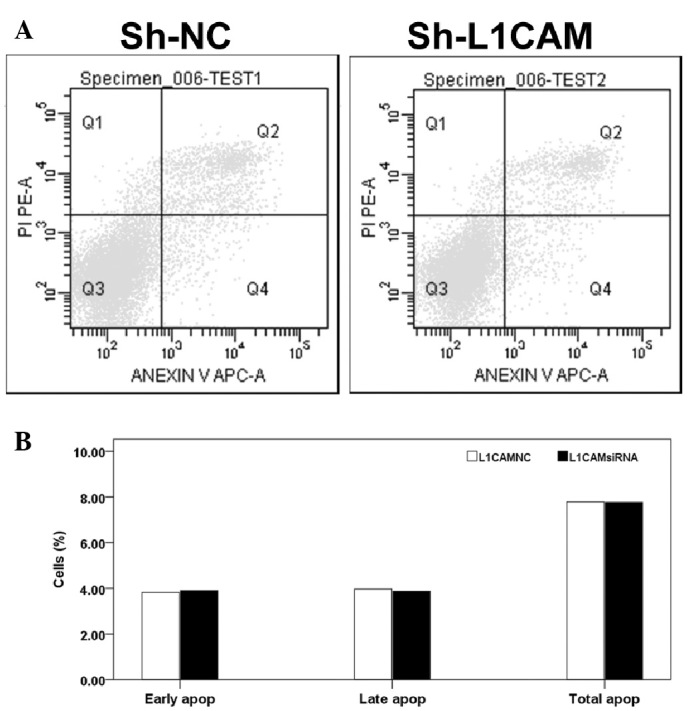
Effect of L1CAM silencing on apoptosis in Capan-2 cells. (A) Flow cytometric analysis demonstrating the effect of L1CAM silencing (Sh-L1CAM) on cell apoptosis. (B) Analysis of the cellular subpopulations during early apoptosis, late apoptosis and total apoptosis relative to the NC (Sh-NC) showed that the effect was not statistically significant (P>0.05). NC, negative control; L1CAM, L1 cell adhesion molecule; siRNA, small interfering RNA; Sh, short hairpin.